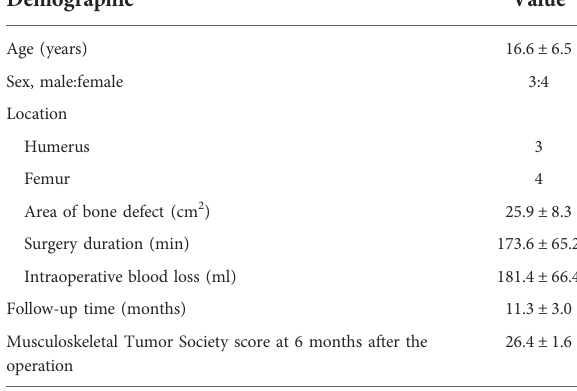
TABLE 1 Osteochondroma patients ’ demographics ( n